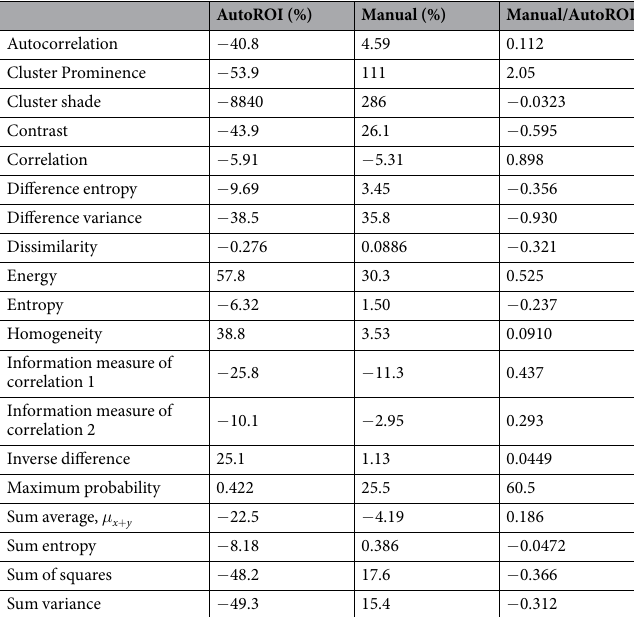
Table 1. Percentage change in texture features when expanding the ROI by one voxel. The sensitivity of AutoROI and a manual level of 500 and 1500 mm 2 /s to the definition of the ROI for a patient with a tumor close to the left lateral ventricle, in the slice shown in Fig.